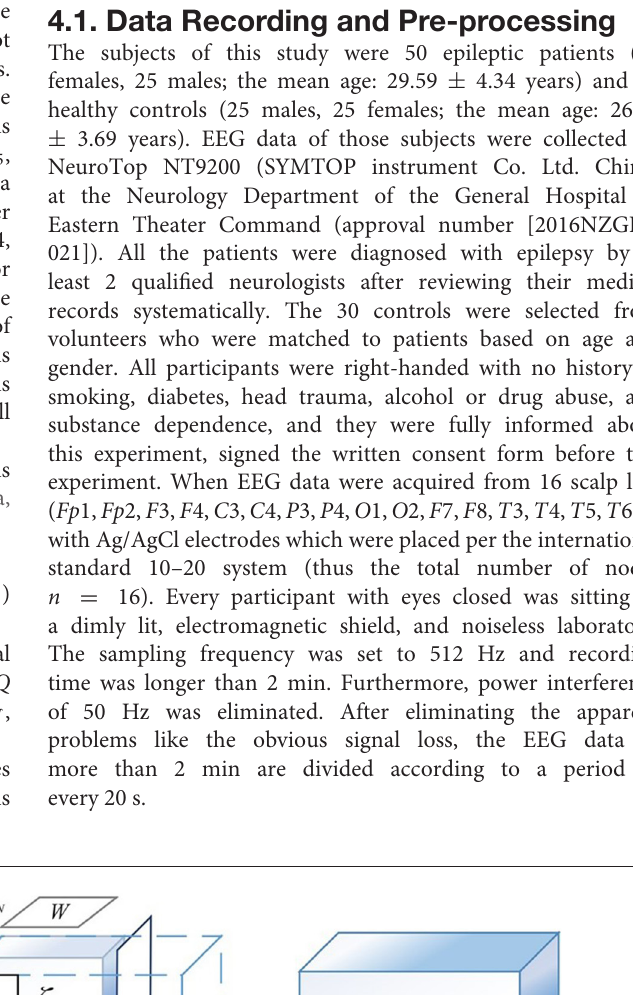
Frontiers in Neuroscience |